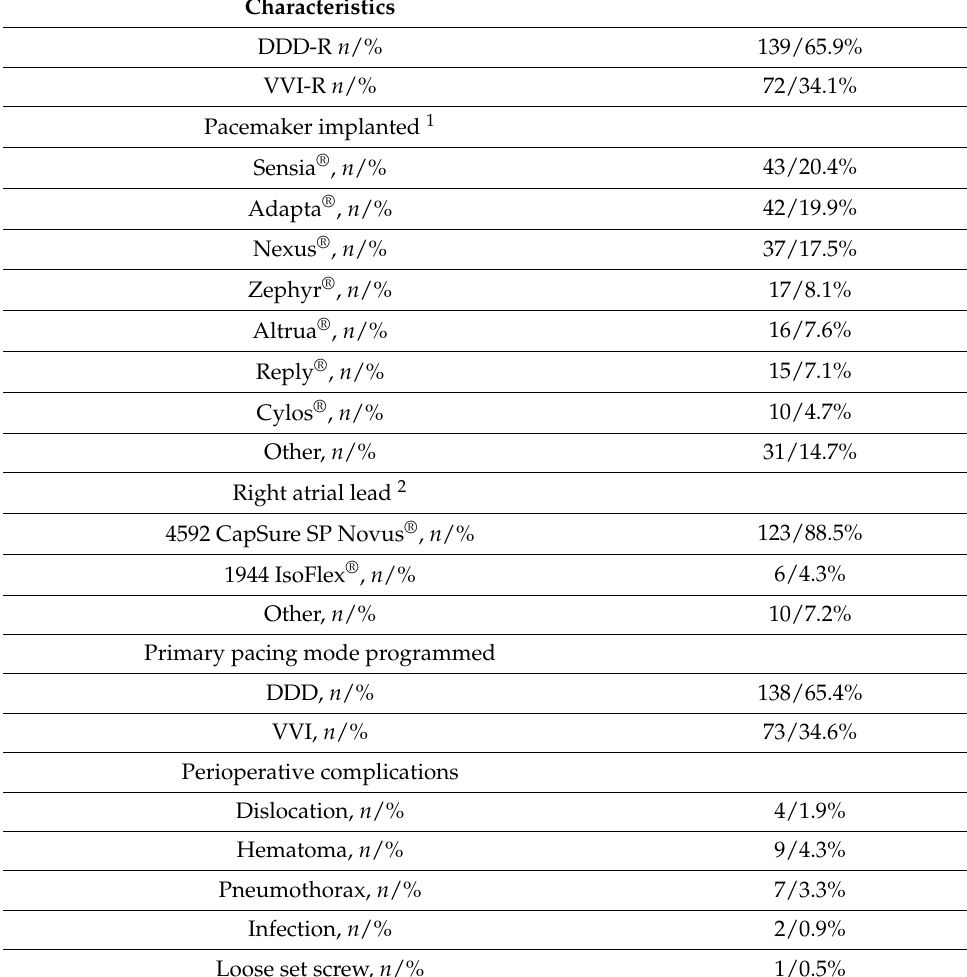
Table 2. Perioperative